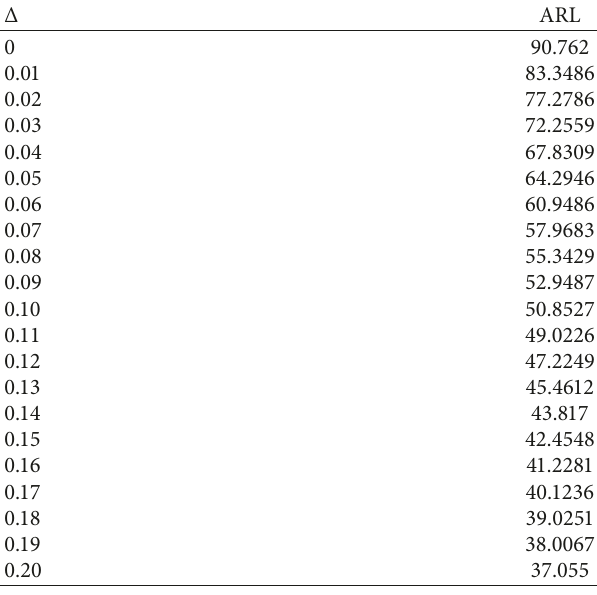
� 2, ϕ � 1, and h � 5 . 03. 1